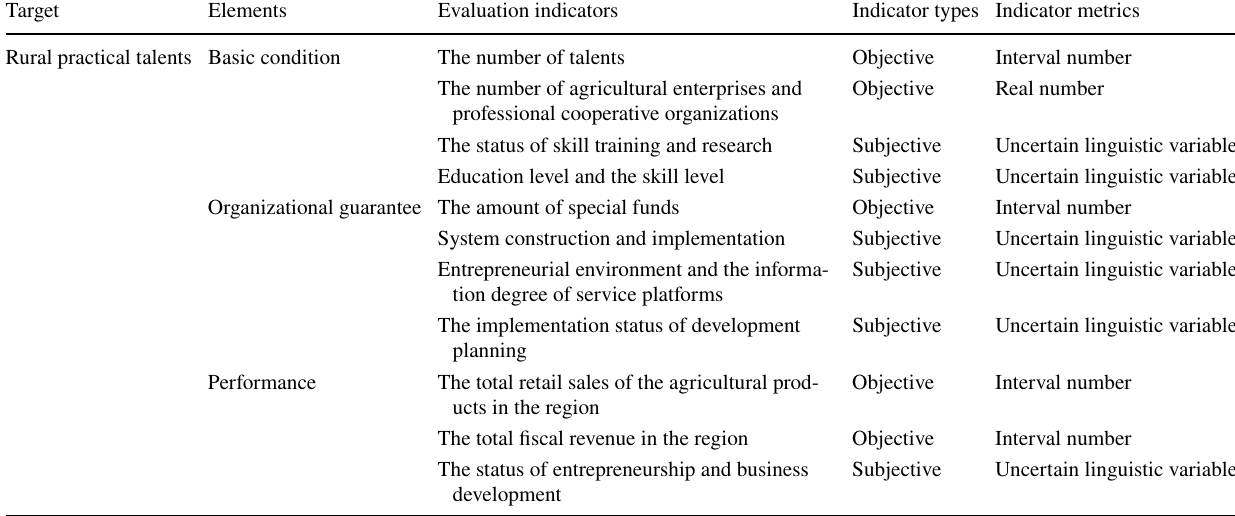
Table 1 A comprehensive evaluation indicator system of the rural practical talents in a region